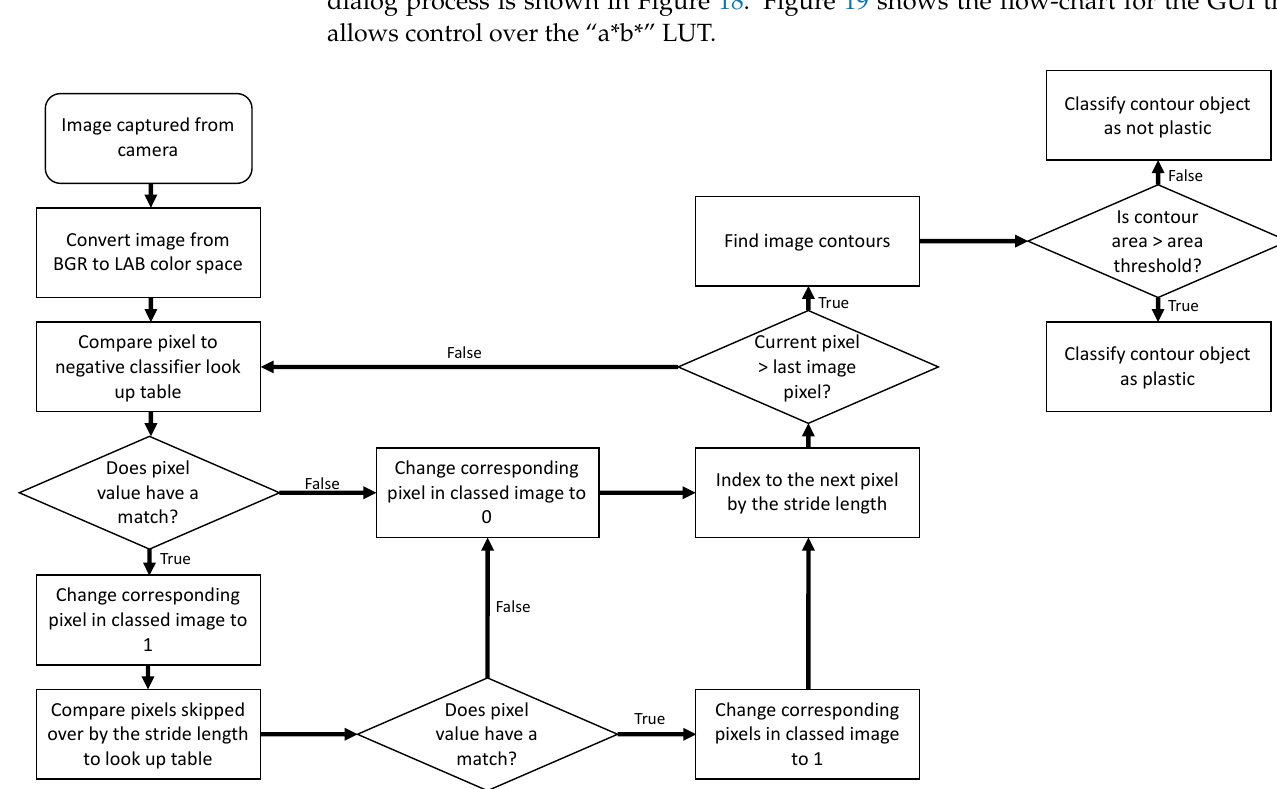
Figure 18. Flow chart detailing the building of a negative classifier.